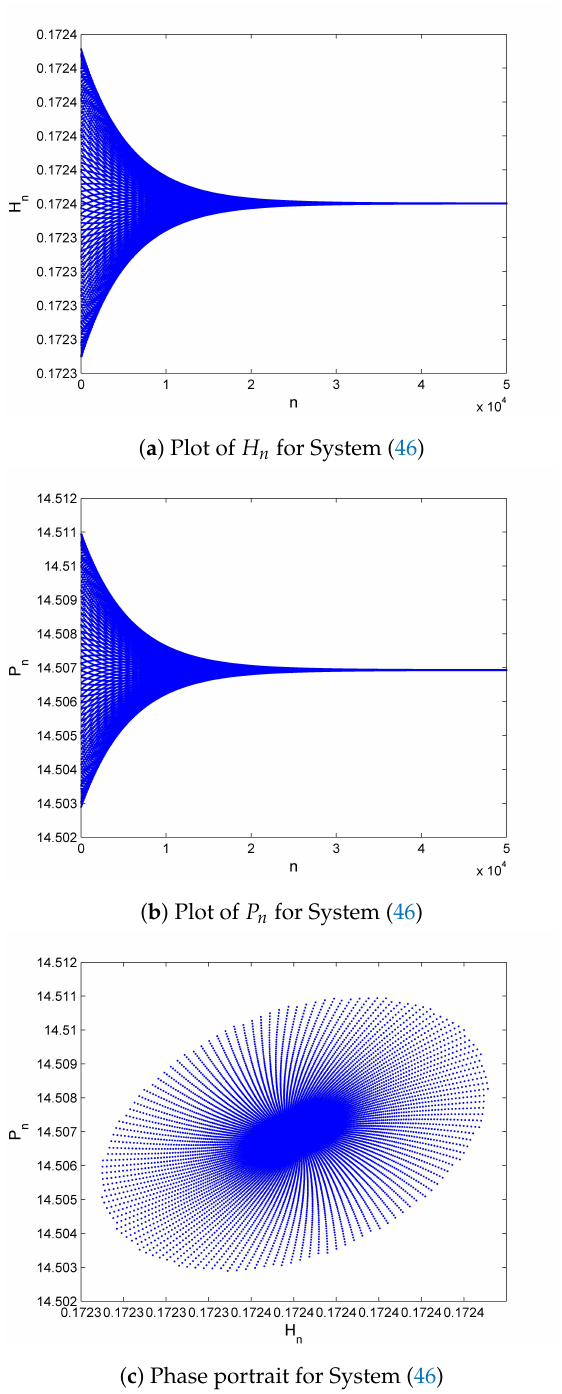
Figure 7. Plots for the controlled System (46) with α = 0.9995 and initial conditions ( H 0 , P 0 ) = ( 0.1724,14.51 )